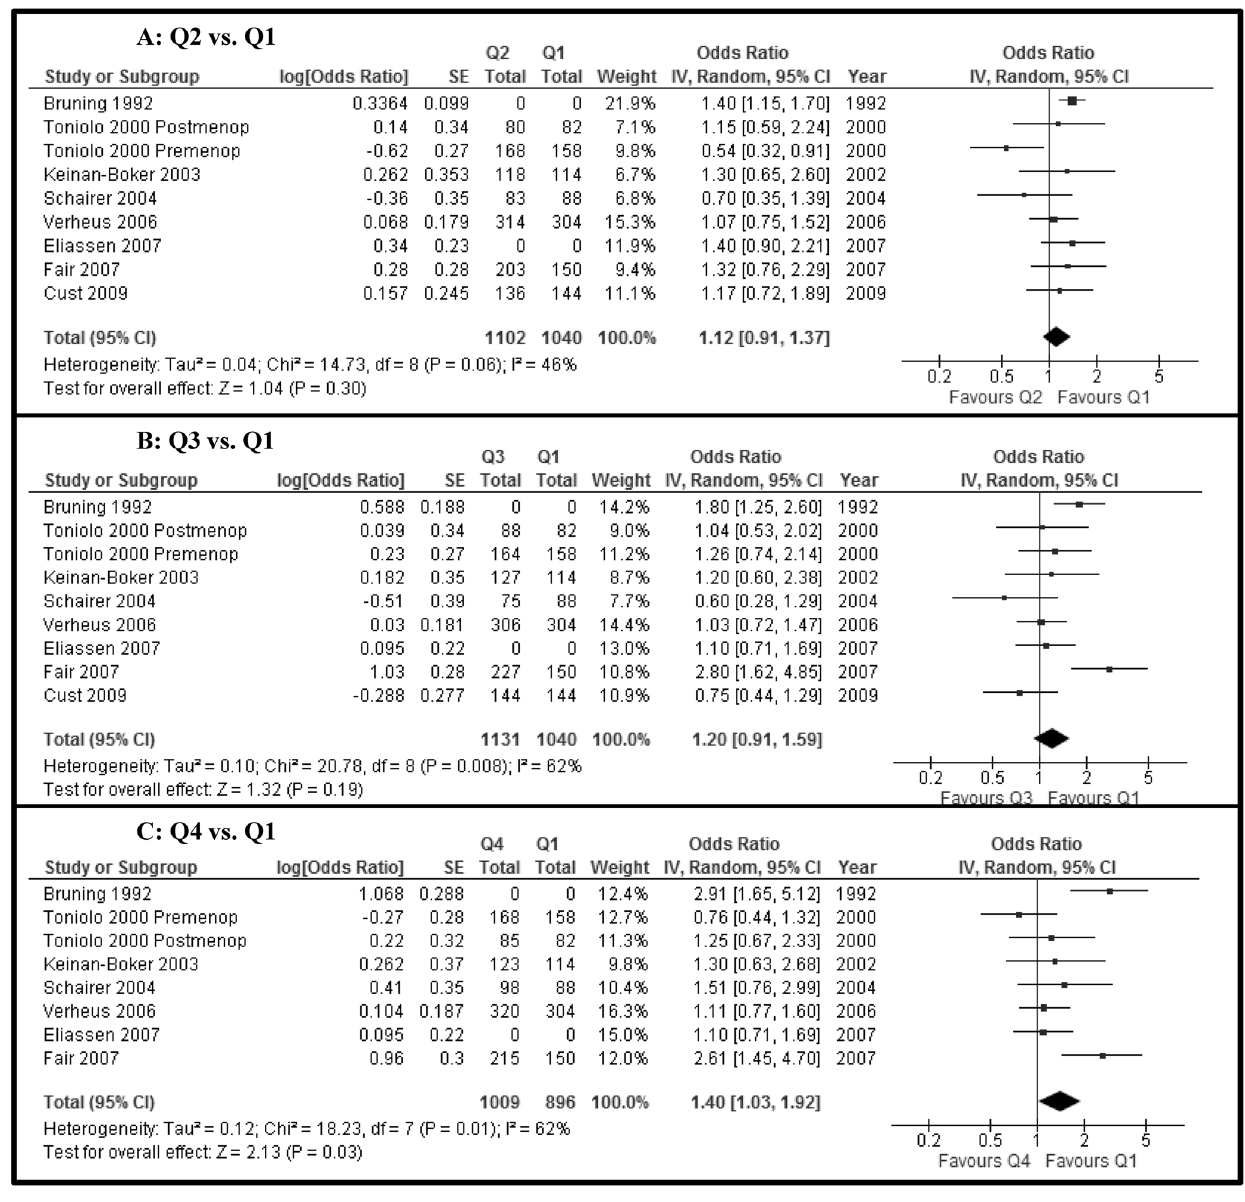
Figure 4. Forest plot of observational studies with adjusted ORs for breast cancer between quartiles of non-fasting/fasting C- peptide levels (A) Q2 versus Q1; (B) Q3 versus Q1; (C) Q4 versus Q1. (IV, Random= Inverse variance, Random effects model.)